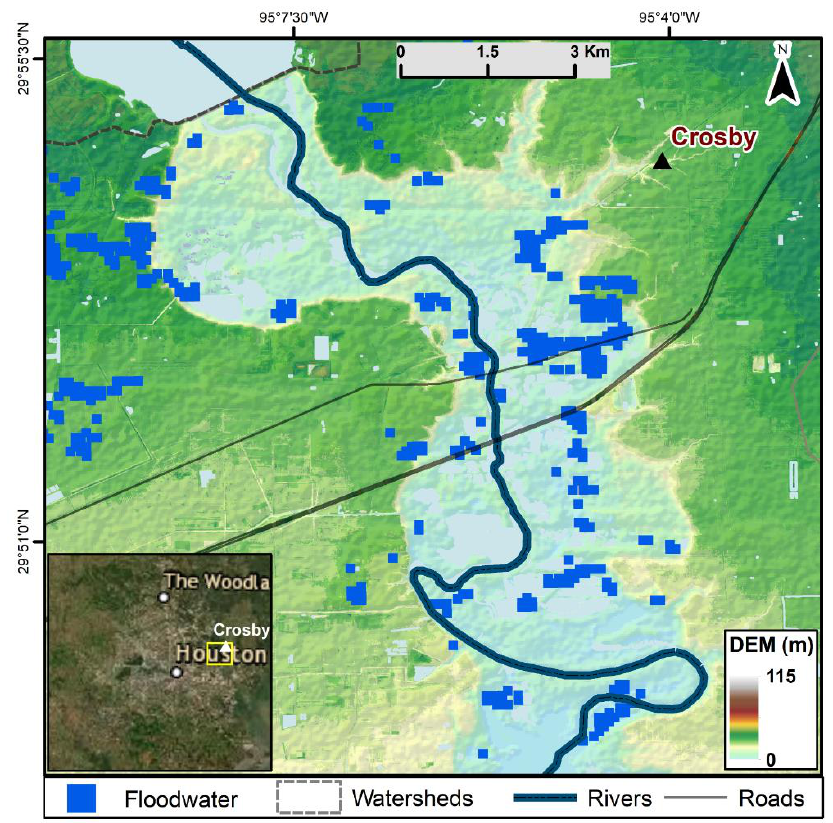
Figure 7. Flooding along the course of the San Jacinto River, particularly affecting the low-lying areas proximal to the course of the flow.